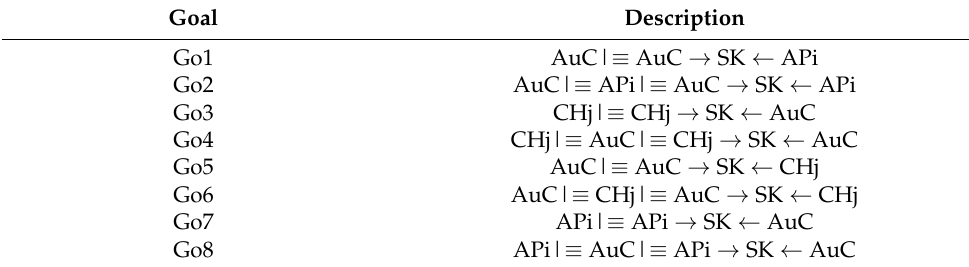
Table 3. Goals of authentication and key agreement phase.